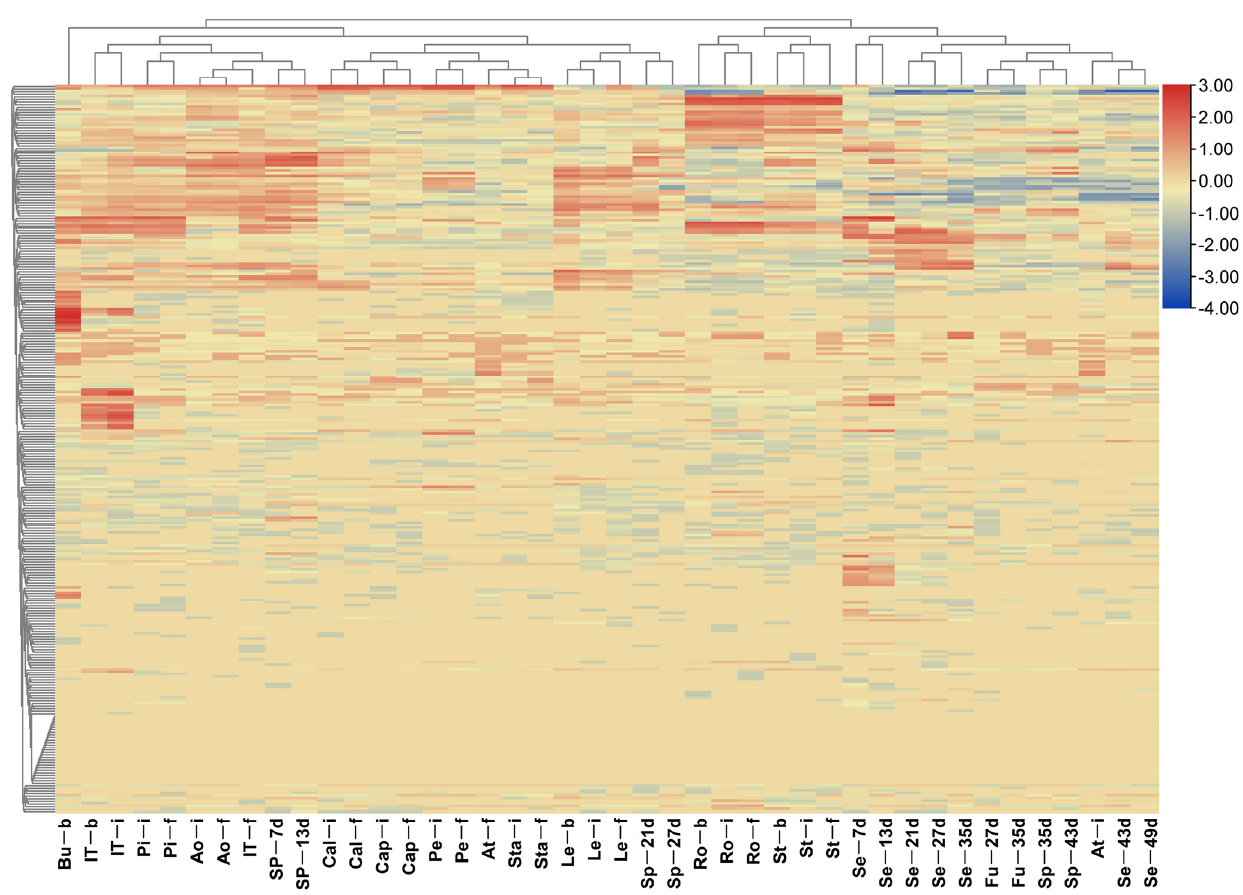
Figure 4. Expression patterns of BnLTP genes in 42 various tissues and organs. The abbreviations combinations of 42 samples of B. napus cultivar ZS11 are listed in supplementary Table S11. The corresponding heatmap containing BnLTP gene names is shown in supplementary Figure S3.